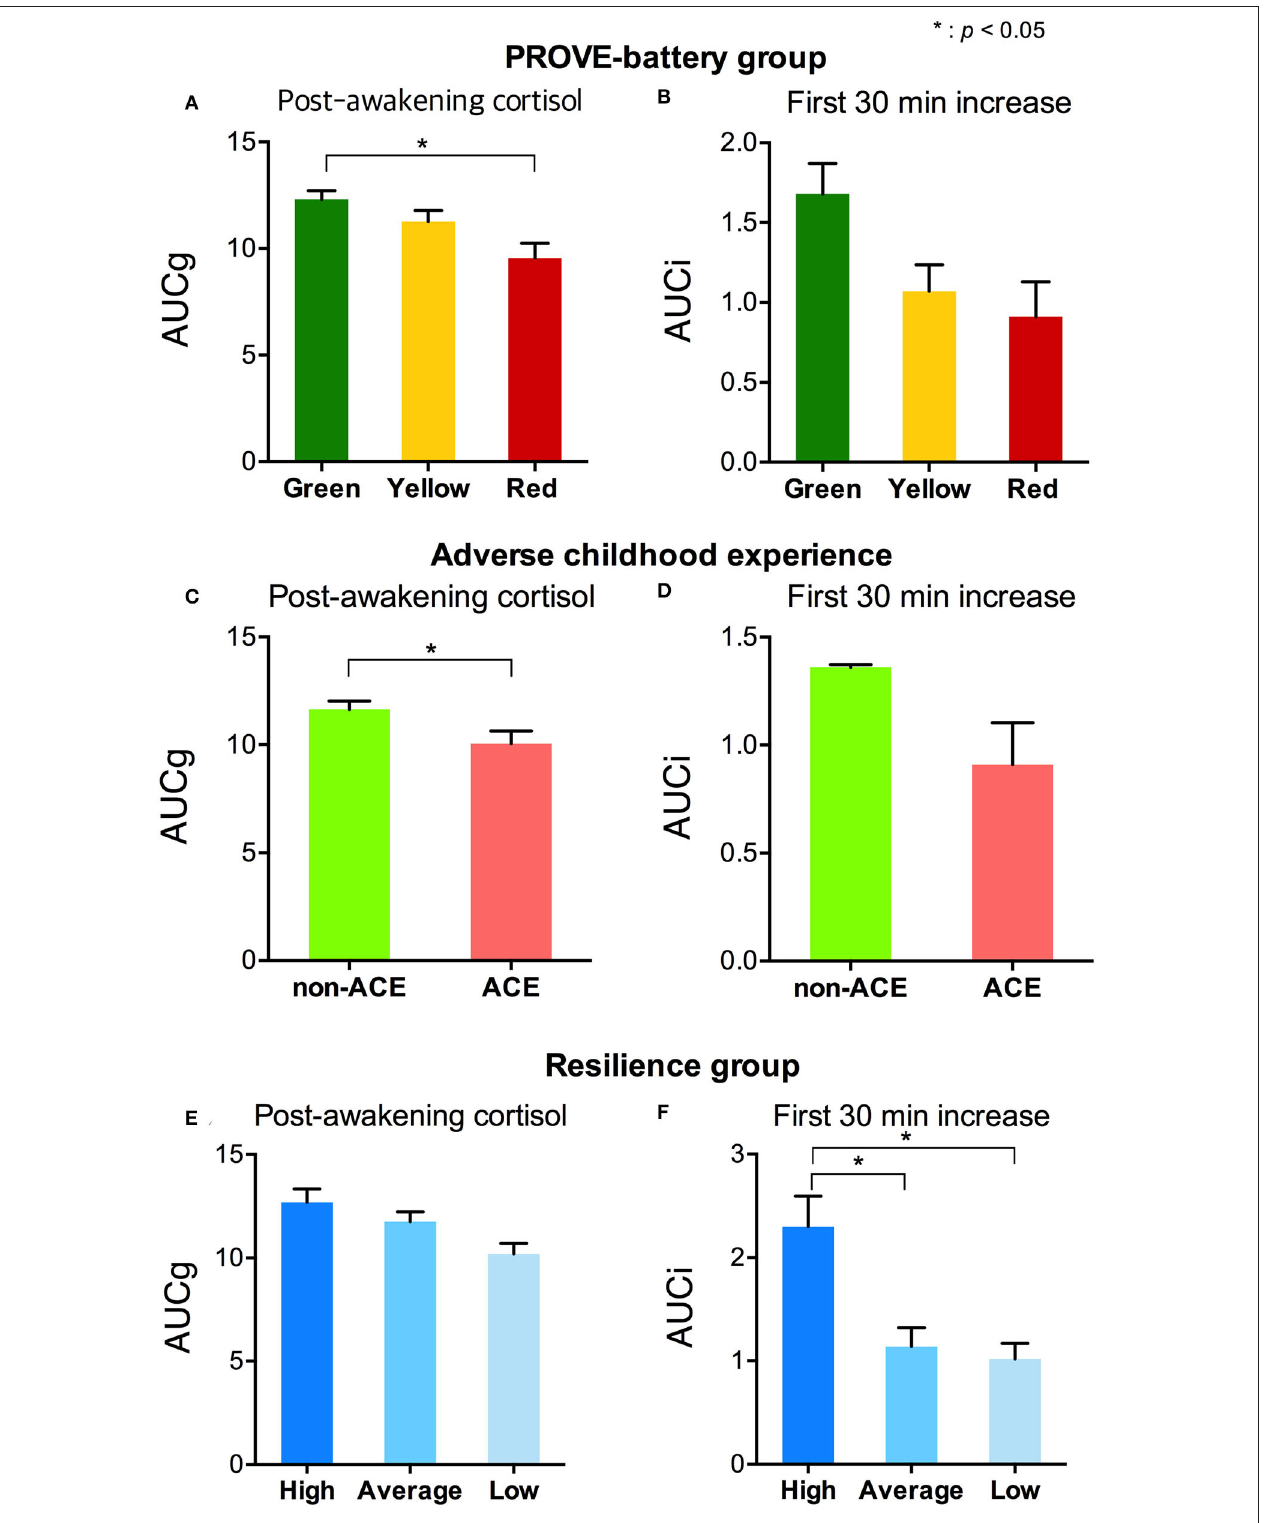
FIGURE 3 | Stress-related salivary cortisol indicators by the group with PROVE battery, presence of ACE, and resilience group. (A) AUCg and (B) AUCi of each PROVE-battery group were represented. (C) AUCg and (D) AUCi were shown according to the presence or absence of an adverse childhood experience. Differences of (E) AUCg and (F) AUCi by each level of resilience were presented. PROVE, PROtective and Vulnerable factors battEry questionnaire; ACE, adverse childhood experience; AUCg, area under the curve with respect to the ground of post-awakening cortisol concentrations; AUCi, area under the curve with respect to the increase of cortisol awakening response. * p <